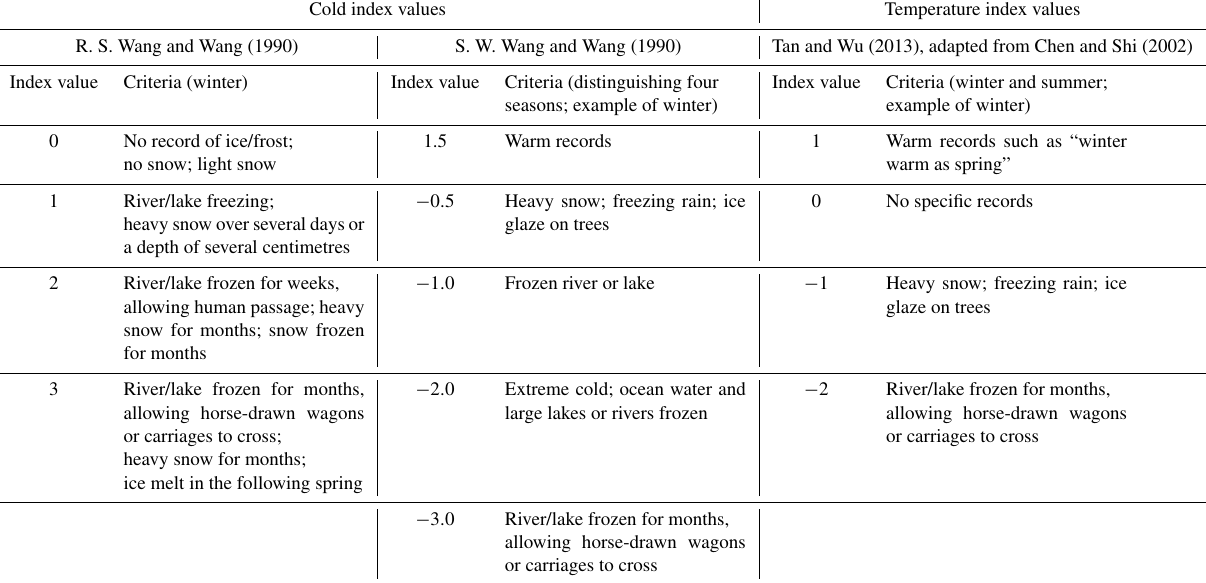
Table 3. Criteria used in the development of temperature indices in